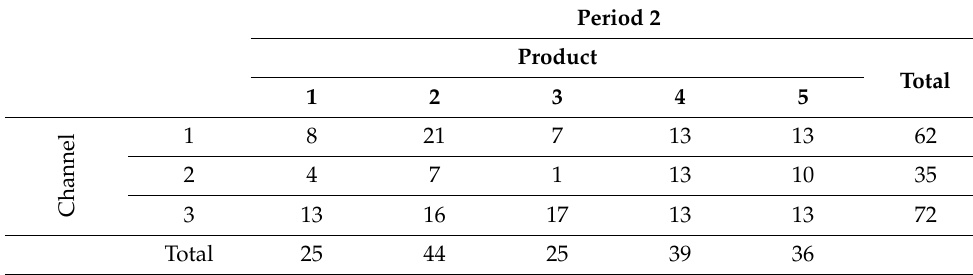
Table 4. Sales forecasting. Number of units of each type of product for each channel during period 2.